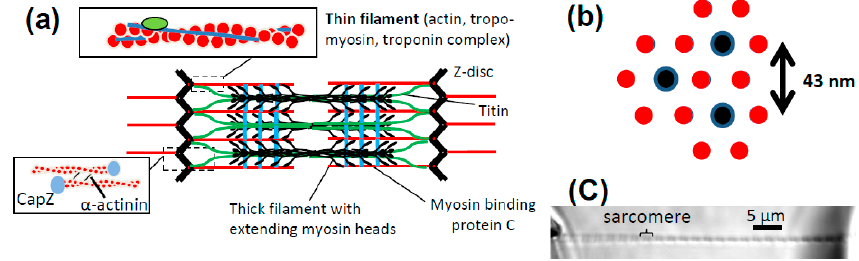
Figure 1. Myofibrils and the functional unit of muscle. ( a ) Schematic of one sarcomere (region between two Z-discs; length ~2 μ m) with key protein components; ( b ) cross-section of the overlap region between actin and myosin in the sarcomere showing each thick filament surrounded by six thin filaments with and overall 2:1 ratio between the number of thin filaments and thick filaments. Same color coding as in ( a ) . Center-to-center distance of thick filaments from [10]; ( c ) myofibril isolated from rabbit psoas muscle and mounted for mechanical experiments.